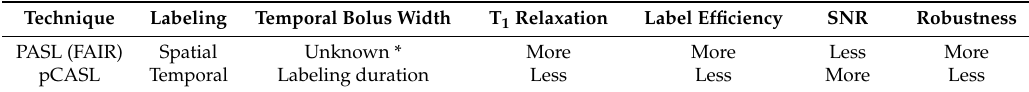
Table 1. General comparison of labeling schemes in ASL.